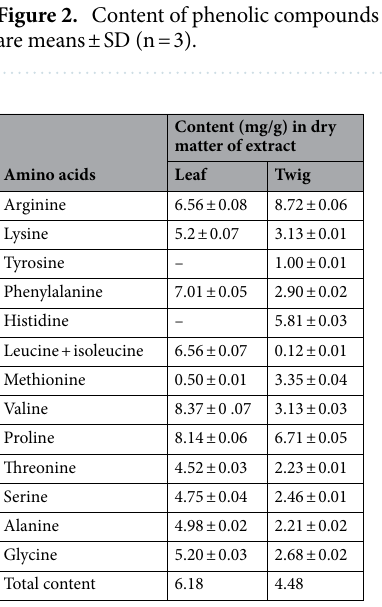
Table 2. Total amino acid content in dry matter of extracts of twigs and leaves from Hippophae rhamnoides L. Values are means ± SD (n = 3).